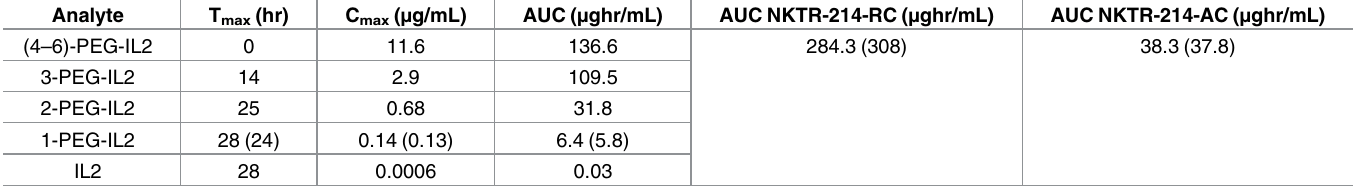
Table 3. T max, C max, and AUC of the individual species calculated from the model. Where available, the values from the PK study (Table 2) are shown in parentheses and in the last 2 columns for ease of comparison. Analyte